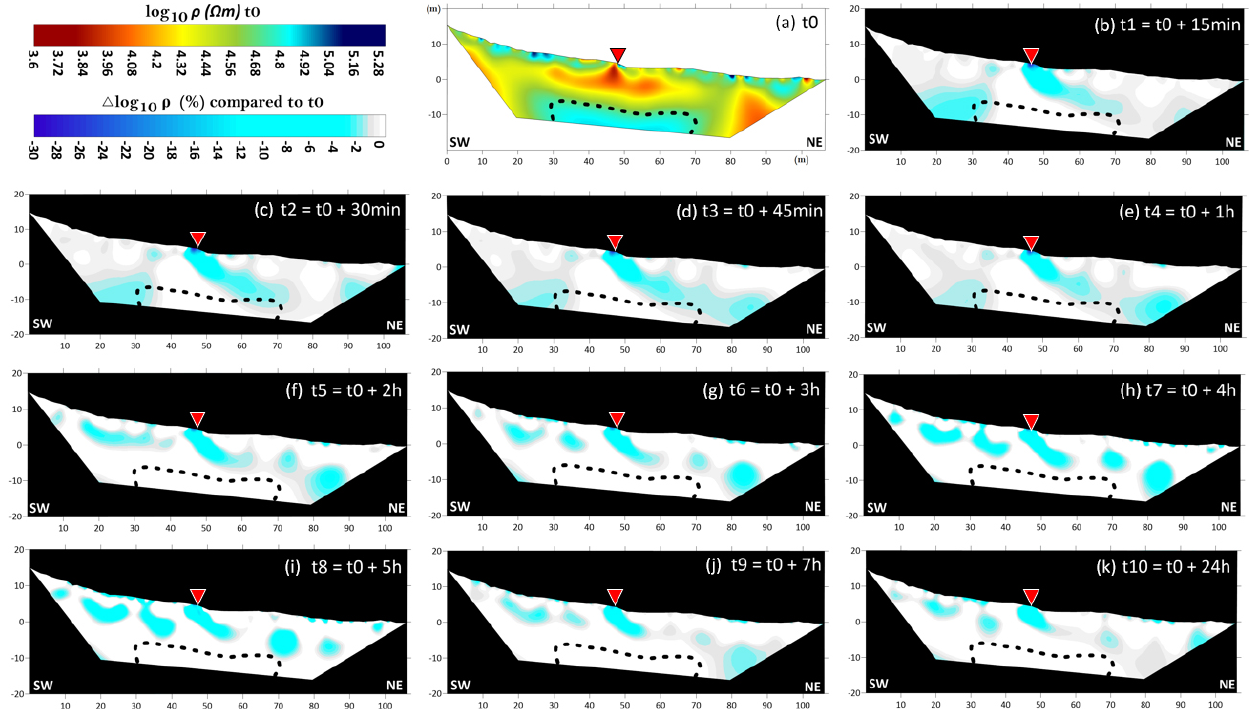
Figure 3. (a) Inverted resistivity section calculated from the t0 dataset. Inverted resistivity variations (%) compared to t0 model, calculated using the logarithmic values, for (b) t1 dataset (t0 + 15min), (c) t2 dataset (t0 + 30min), (d) t3 dataset (t0 + 45min), (e) t4 dataset (t0 + 1h), (f) t5 dataset (t0 + 2h), (g) t6 dataset (t0 + 3h), (h) t7 dataset (t0 + 4h), (i) t8 dataset (t0 + 5h), (l) t9 dataset (t0 + 7h) and (m) t10 dataset (t0 + 24h). The black dashed line represents the boundary of the frozen layer defined applying the steepest gradient method to the inverted resistivity model t0. Red triangles represent the injection point of 800L of